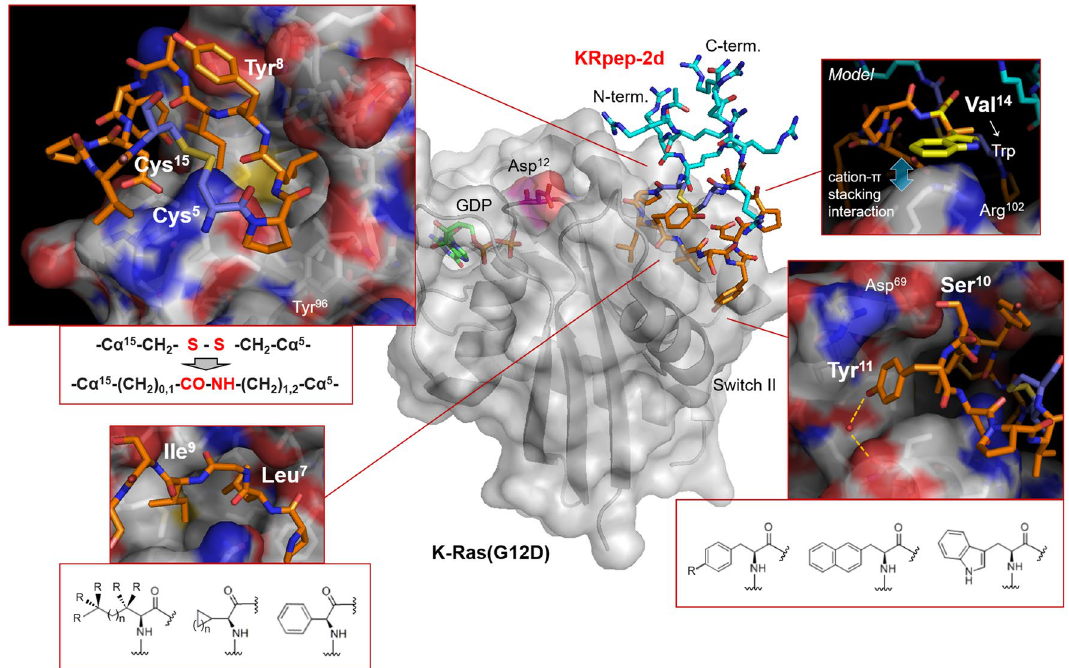
Figure 2. Prediction and design of amino acid substitutions in each amino acid position of KRpep-2d. The complex of ribbon diagram of K-Ras(G12D) GDP and stick model of KRpep-2d (PDB ID: 5XCO) are shown in the center. Purple amino acids are Cys 5 and Cys 15 . Orange amino acids indicate pharmacophore sequence (Pro 6 –Val 14 ). Cyan amino acids present Arg 1–4,16–19 residues. Chemical structures of representative amino acid examples that were predicted to improve biochemical functions of KRpep-2d in Leu 7 , Ile 9 , and Tyr 11 are listed. In the upper left side box, Arg residues at both termini of the KRpep-2d were excluded for clarity. The figure was made using